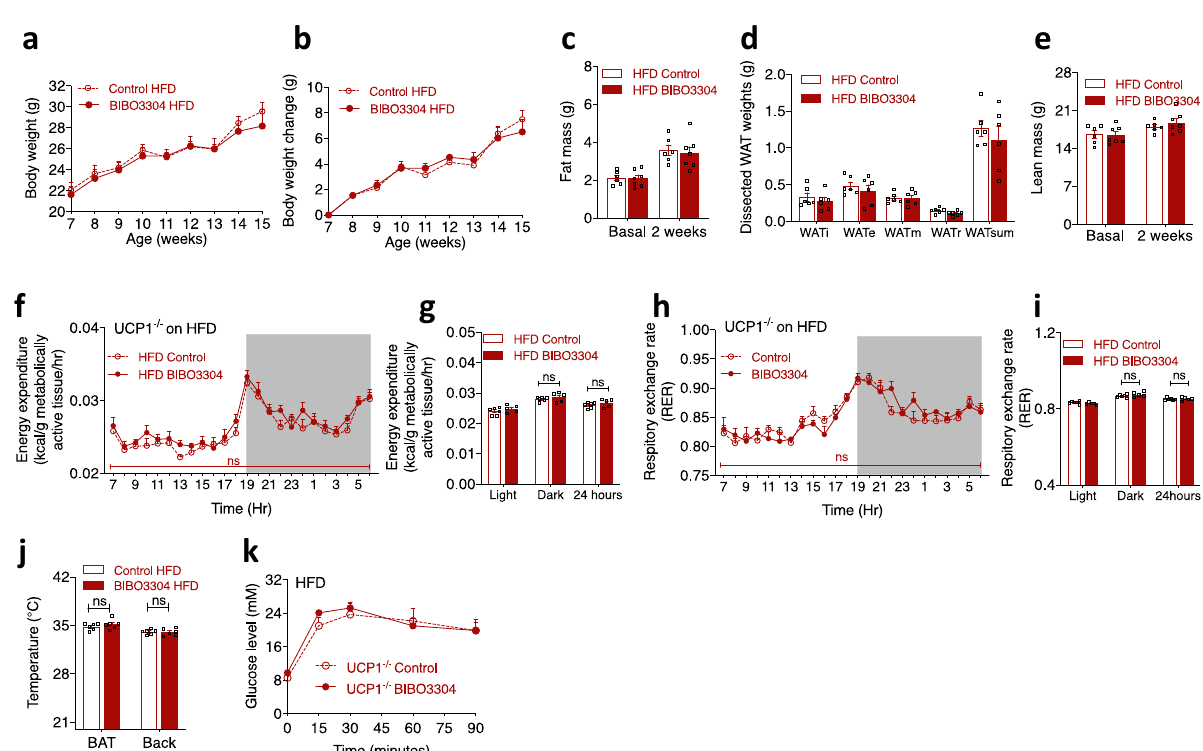
Fig. 7 UCP1 is required for the weight-loss effects of BIBO3304 on a high-fat diet. a , b Body weight curve and body weight change of UCP1 − / − mice on a high-fat diet administered daily with either a jelly containing vehicle (control) or BIBO3304 for 8 weeks. Data are mean ± s.e.m, n = 6 per group (control: open circle; BIBO3304: fi lled circle). p values by two-way repeated measures ANOVA. c Whole-body fat mass of vehicle- and BIBO3304-treated UCP1 − / − mice on a HFD determined by DEXA at baseline and after 2 weeks of treatment. d Dissected weights of individual WAT from inguinal (WATi), epididymal (WATe), mesenteric (WATm), retroperitoneal (WATr) and total weights of these 4 depots (WATsum) at cull. e Whole-body lean mass of vehicle- and BIBO3304-treated UCP1 − / − mice on a HFD determined by DEXA at baseline and after 2 weeks of treatment. Data are mean ± s.e.m, n = 6 per group (control: open red; BIBO3304: red). p values by two-sided t test ( c , d , e ). f , g Energy expenditure, h , i RER of vehicle- and BIBO3304-treated UCP1 − / − mice on a HFD over a 24 h course during an indirect calorimetry study at 13 weeks of age. Data are mean ± s.e.m, control n = 6 (open circle), BIBO3304 n = 5 ( fi lled circle). p values by two-way repeated measures ANOVA. j Temperature measured by infra-red camera of BAT and lumbar back regions of HFD-fed UCP1 − / − mice given vehicle or BIBO3304 jelly at 11 weeks of age. Data are mean ± s.e.m, control n = 6 (open red), BIBO3304 n = 5 (red). p values by two- sided t test within the same region. k Glucose levels in an intraperitoneal glucose tolerance test (GTT) in vehicle- and BIBO3304-treated UCP1 − / − mice on a HFD at 13 weeks of age. Data are mean ± s.e.m. n = 6 per group (control: open circle; BIBO3304: fi lled circle). p values by two-way repeated measures ANOVA. ns non-signi fi cance. Source data are provided as a Source Data fi